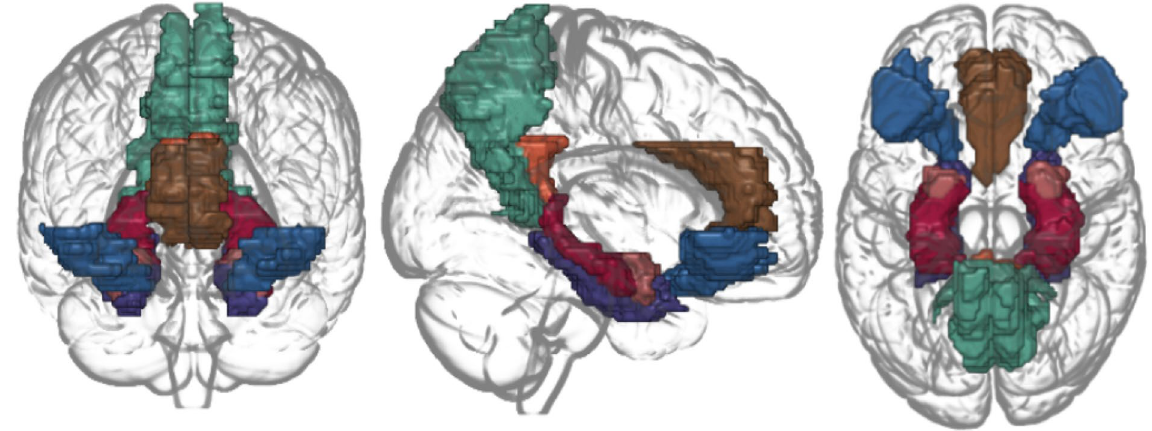
Figure 6. Social anxiety-related brain regions included in the current study. The regions were the orbitofrontal cortex (blue), anterior cingulate cortex (brown), posterior cingulate cortex (orange), precuneus (green), hippocampus (red), parahippocampal gyrus (purple), and amygdala